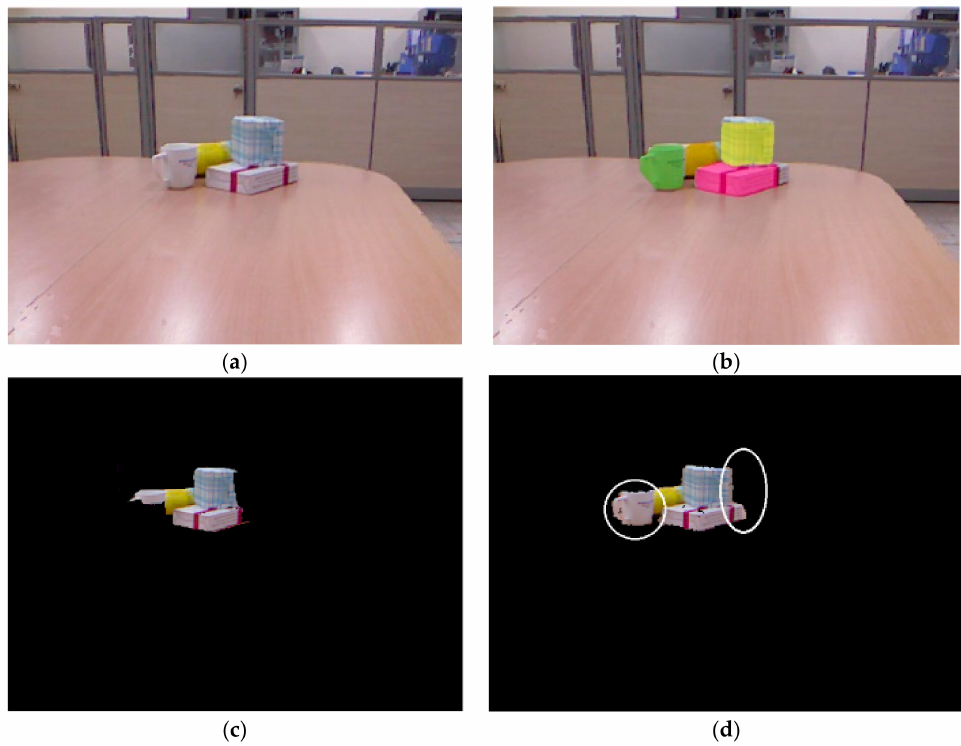
Figure 3. Comparison between results of Mask R-CNN (original) with GrabCut and DoN. The weakness of Grabcut compared with DoN is shown inside the white circle. ( a ) Original image. ( b ) Mask R-CNN. ( c ) Grabcut. ( d )